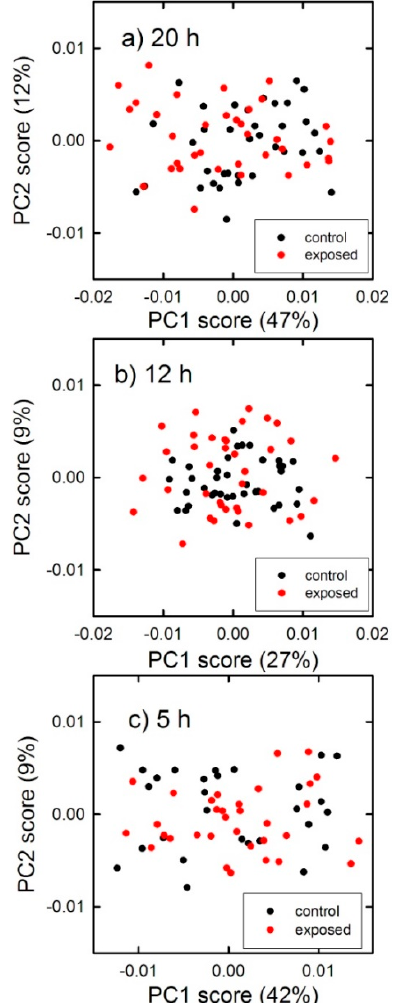
Figure 3. Score plots of the 1st and 2nd principal component of Raman spectra obtained by means of PCA technique. The data refer to the spectra of the unexposed (black dots) and electromagnetic fields (EMFs) exposed (red dots) for 20 ( a ), 12 ( b ) and 5 ( c ) hours.